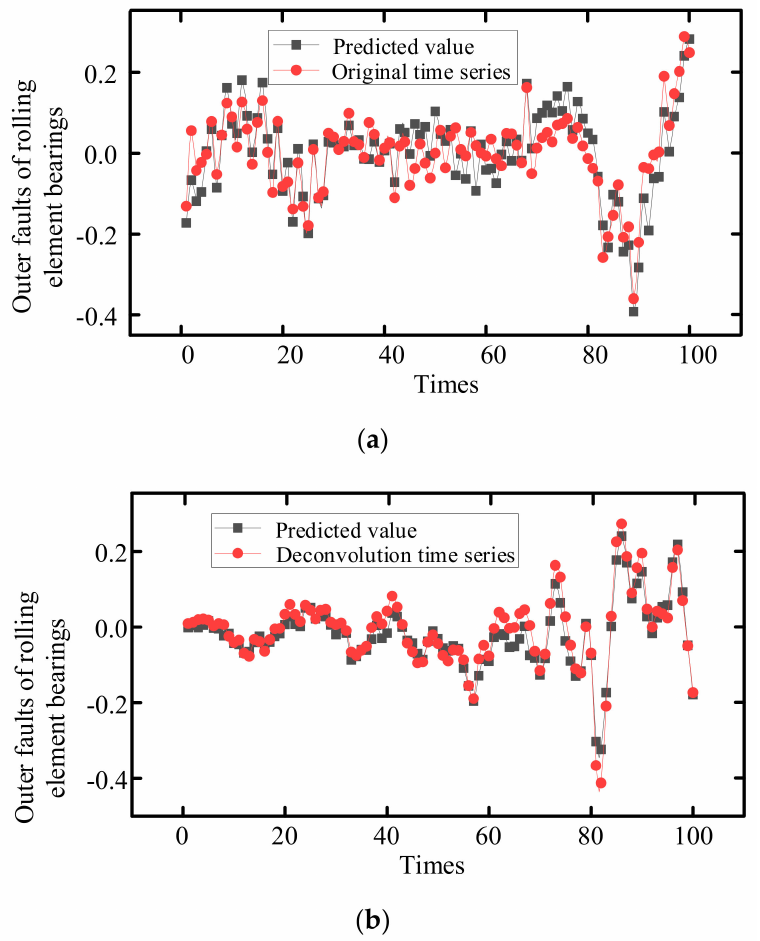
Figure 10. Timeseries prediction results. ( a ) Prediction results of original time series. ( b ) Prediction results of deconvolution time series. Table 4. The central frequencies of IMF components corresponding to different K